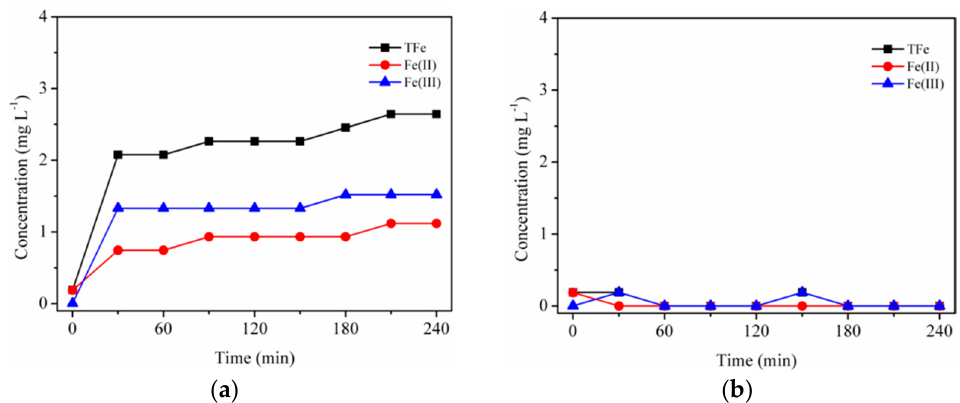
Figure 2. Dissolution kinetics with suspensions of 0.1 g L − 1 Fhy ( a ) under UV illumination and ( b ) in the dark at pH 3.0 without oxalic acid.